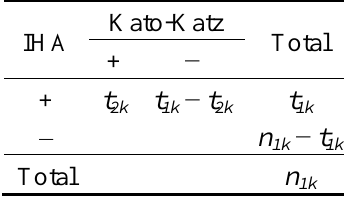
Table 1. Cross-classified data of IHA test and Kato-Katz test for the k th